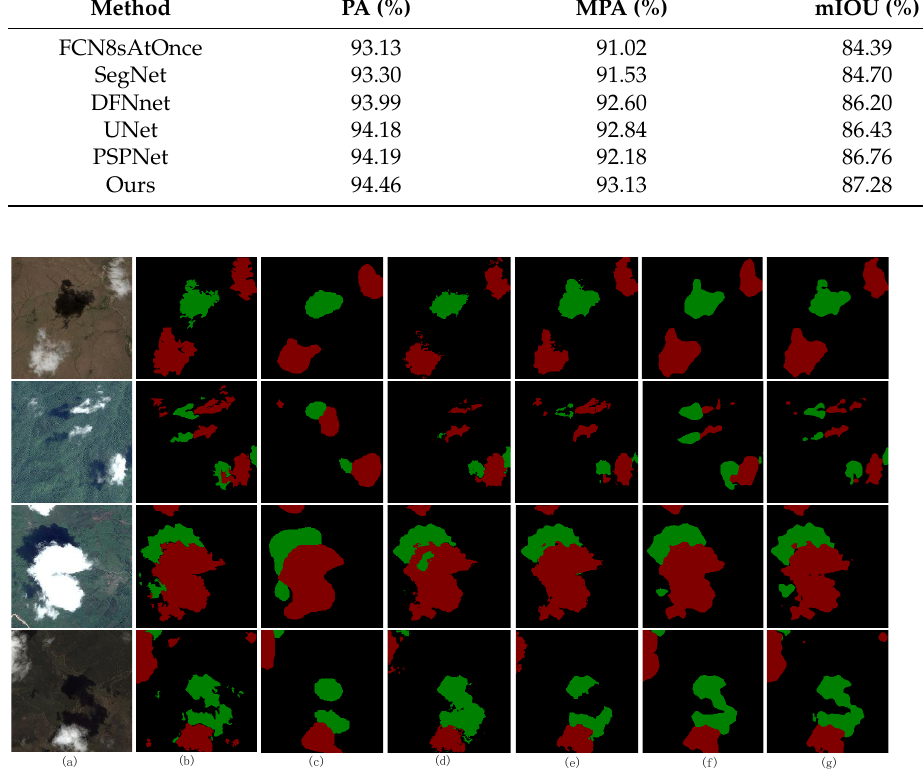
Figure 13. ( a ) Image; ( b ) label; ( c ) FCN8sAtOnce; ( d ) Segnet; ( e ) UNet; ( f ) PSPNet; ( g ) Our